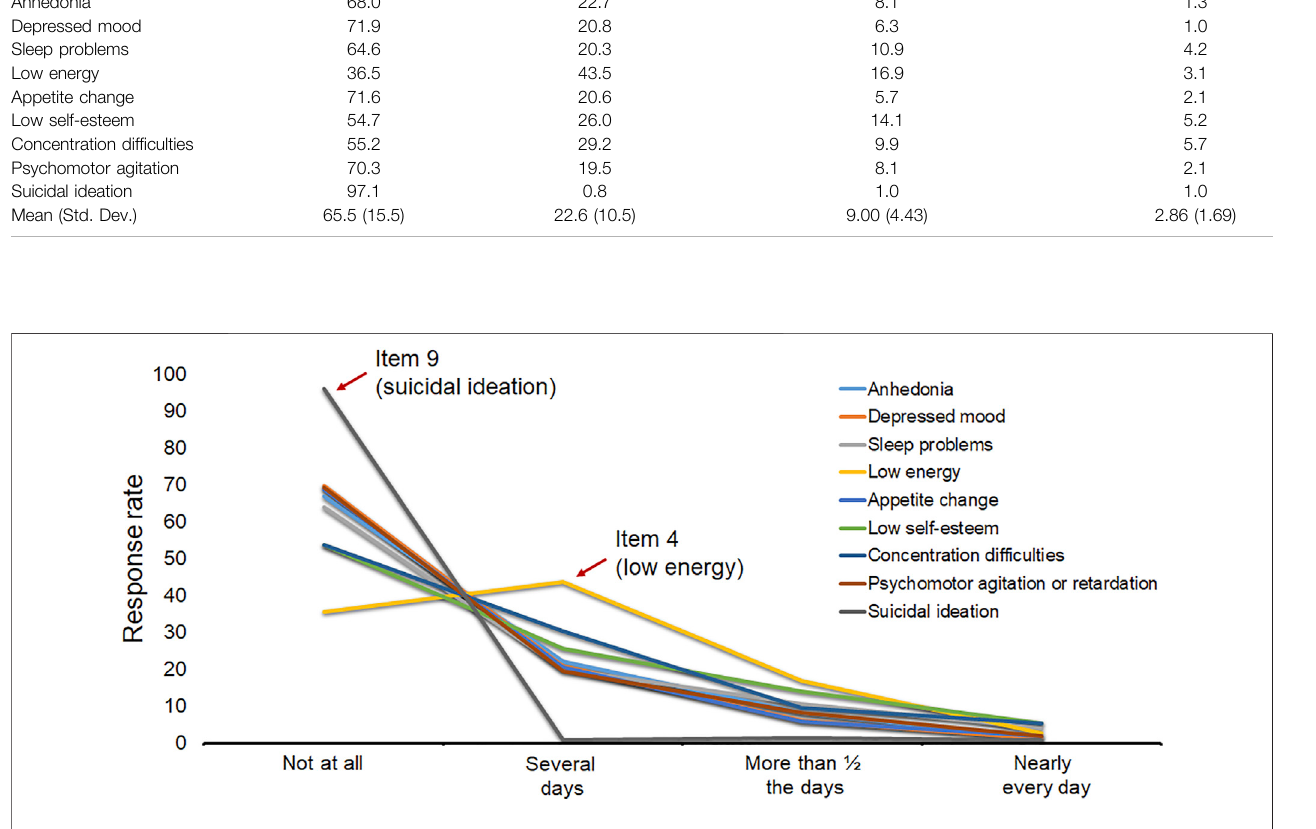
TABLE 3 | Mean, standard deviation, median, interquartile range (IQR) of T-PHQ-9 sum scores, as well as frequency (number and percentage) of monastics falling within eachofthediagnosticcategories.Allscoresarereported1)accordingtomonasticyearformonks,2)fornuns,3)forallmonks,and4)forallmonasticscombined(monks and nuns).